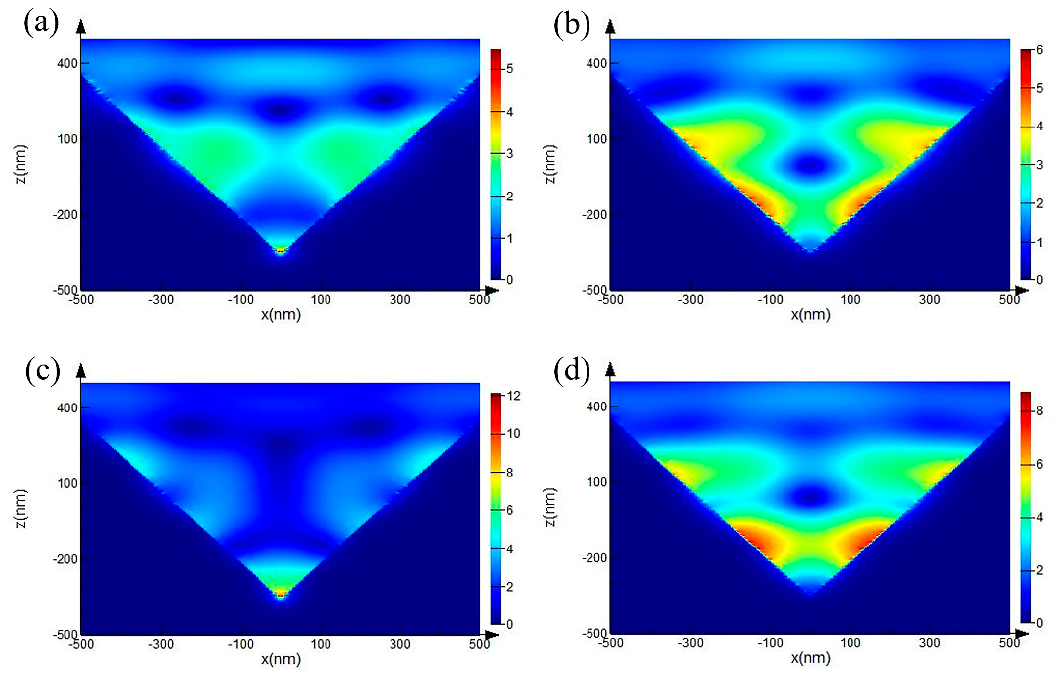
Figure 4. Electric field distribution diagram of a pyramid array in the x-z plane. ( a ) Au/PPS; ( b ) Au/IPS; ( c ) Ag/PPS; ( d ) Ag/IPS.